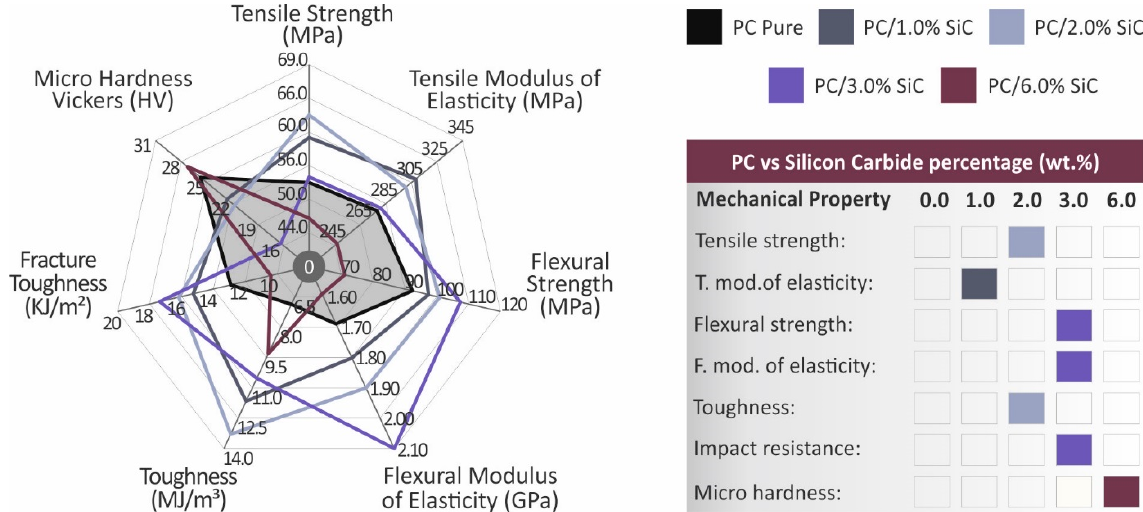
Figure 8. Overview of the results of the mechanical tests. The darkened region indicates the me ‐ chanical response of the unfilled PC. The material exhibiting the highest performance is indicated in the figure, on the right